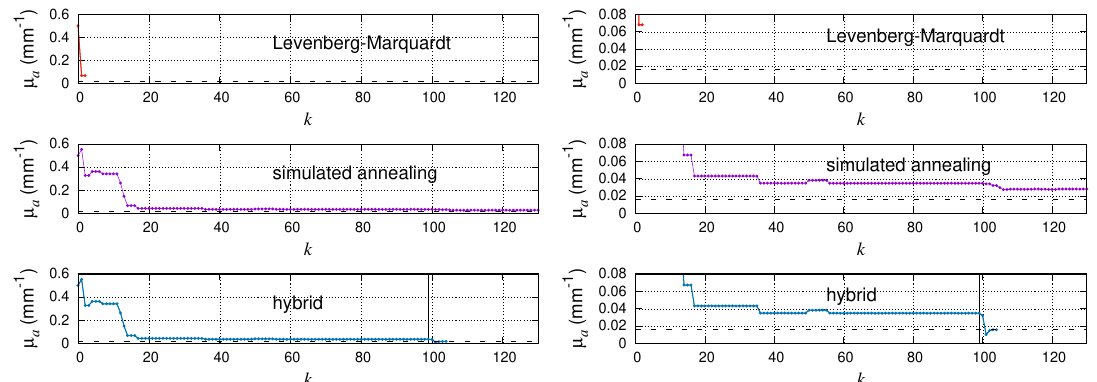
Figure 5. (Left) Case 2: Reconstructed µ a by (top) Algorithm 1, (middle) Algorithm 2, and (bottom) Algorithm 3. The dashed lines show µ a in Equation (42). (Right) Same as the left panel but the vertical axes are from 0 to 0.08.